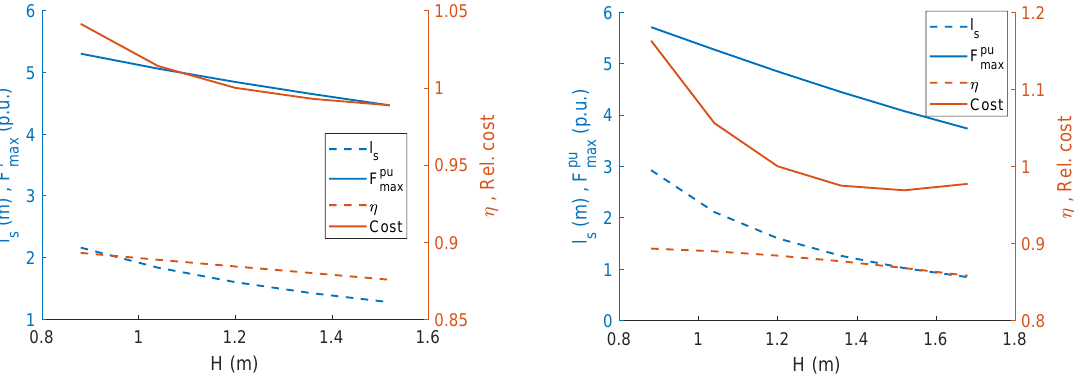
Figure 6. Stator length, maximum damping force in per unit, efficiency and relative cost for the original generator design with varied stator height, H and an adjusted stator length, l s to achieve an output power of 18.4 kW. Left figure: The pole pitch is fixed. Right figure: The number of poles is fixed, so the pole pitch